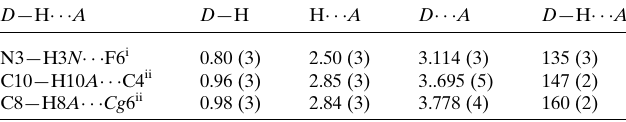
Table 3 Hydrogen-bond geometry (A˚ , (cid:3) ) for 1 . D —H (cid:2)(cid:2)(cid:2) A